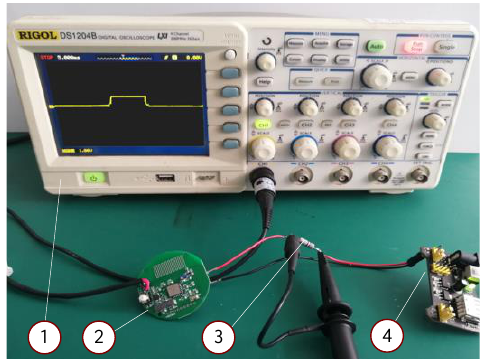
Figure 20. The test system to measure node voltage: (1) oscilloscope, (2) sensor node, (3) a resistor, (4) regulated power supply. Table 2. Summary of test conditions and comparison of the battery current consumption. Chip Operation General Sleep Deep Sleep Parameters Design Design